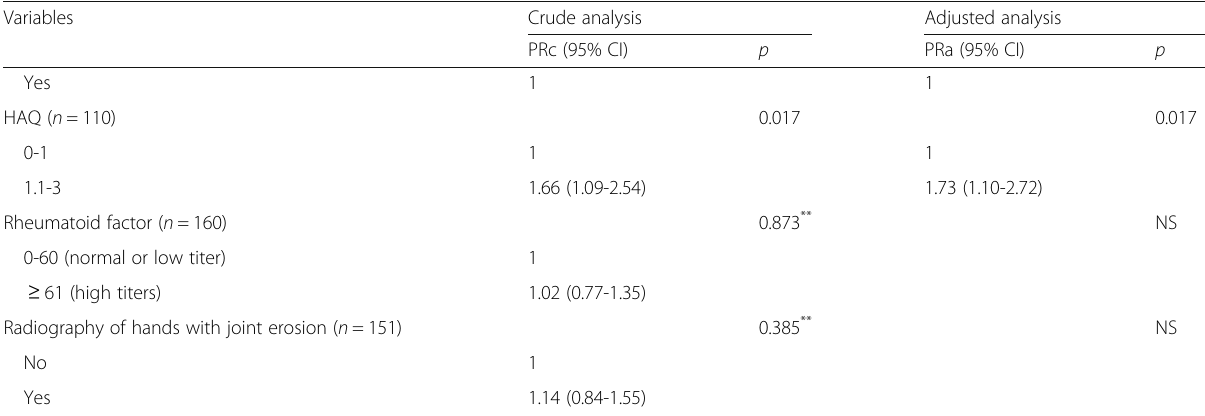
Table 2 Crude and adjusted Poisson regression analyses of the prevalence of working patients with rheumatoid arthritis as a function of independent variables in Blumenau, Santa Catarina state, Brazil, 2014